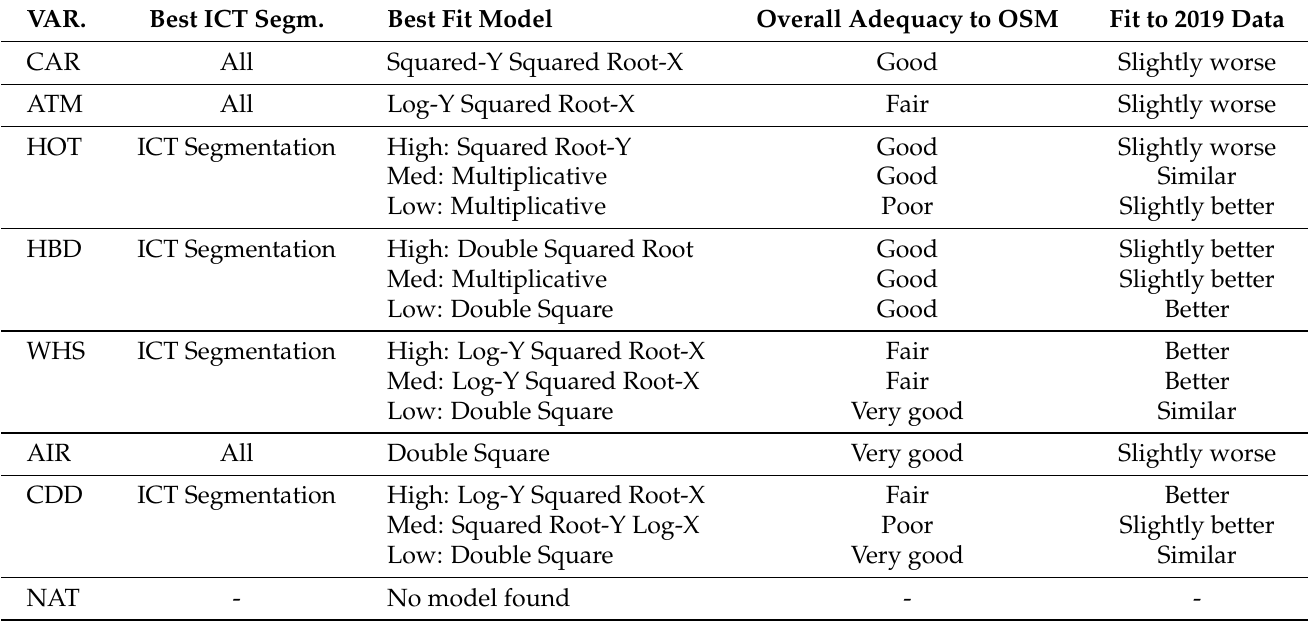
Table 4. Summary of results for all the